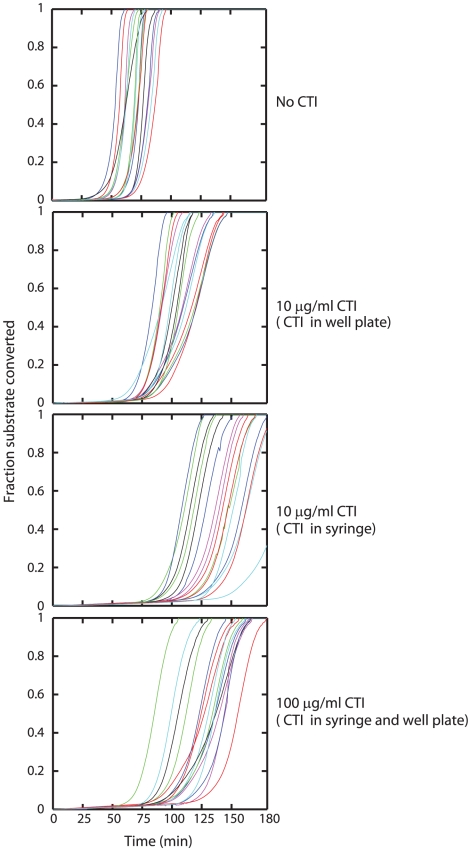
Saturation of the effects of CTI.To evaluate the possibility of leakage past CTI, experiments were conducted with no CTI, CTI addition in well plate, CTI addition during phlebotomy and large quantities of CTI during phlebotomy as well as in well plate. The inclusion of 50 µg CTI/ml whole blood (before a 5× dilution in the well plate) produced saturating effects.